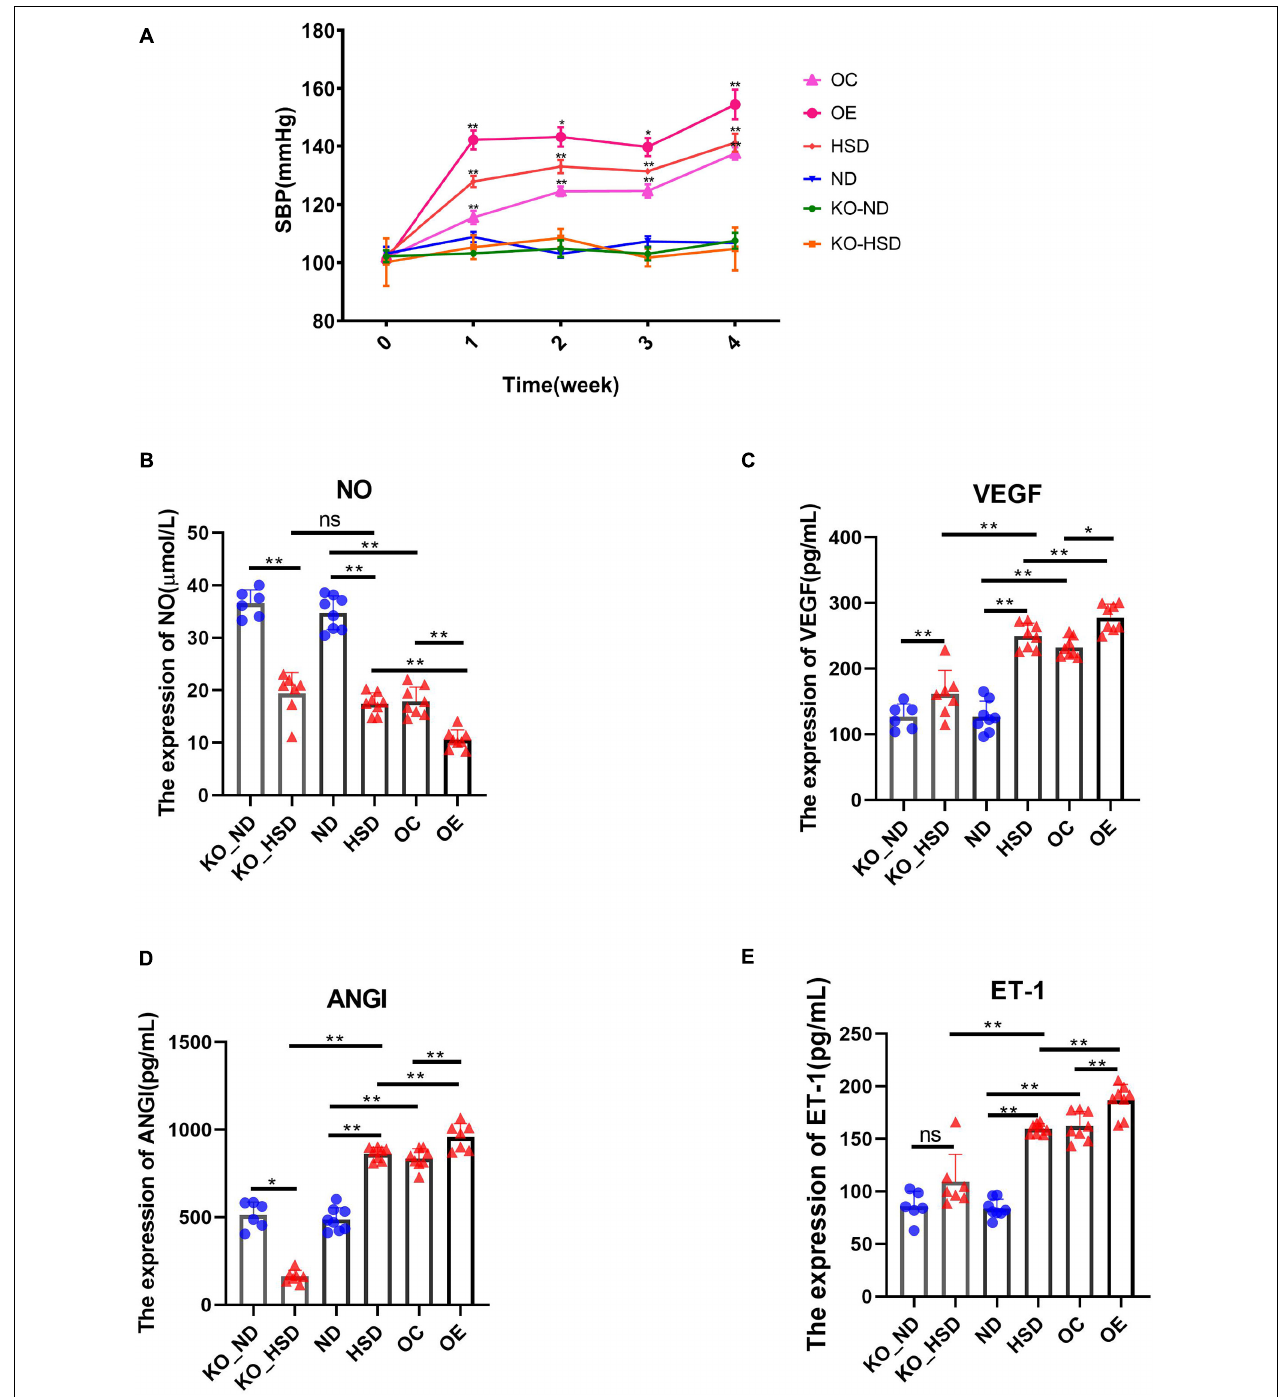
FIGURE 2 | ATF4 altered SBP and endothelial function-related factors in high-salt-induced hypertensive mice. (A) ATF4 altered SBP in high-salt-induced hypertensive mice. ND vs HSD, HSD vs OE, OE vs OC, * p < 0.05 and ** p < 0.01. (B) ATF4 altered the expression of NO in high-salt-induced hypertensive mice. (C) ATF4 altered the expression of VEGF in high-salt-induced hypertensive mice. (D) ATF4 altered the expression of ANGI in high-salt-induced hypertensive mice. (E) ATF4 altered the expression of ET-1 in high-salt-induced hypertensive mice. Data are presented as mean ± SD; ns, no significance, * p < 0.05 and ** p < 0.01, n = 6–8; statistical comparisons were performed using Student t -test or one-way analysis of variance (ANOVA). ATF4, activating transcription factor 4; KO, Atf4 ± mice; WT, wild-type mice; SBP, systolic blood pressure; NO, nitric oxide; VEGF, vascular endothelial growth factor; ANGI, angiotensin I; ET-1, endothelin-1; KO-ND, Atf4 ± mice with natural diet; KO-HSD, Atf4 ± mice with high-salt diet; ND, WT mice with natural diet; HSD, WT mice with high-salt diet; OE, Atf4 overexpression with high-salt diet; OC, Atf4 overexpression control with high-salt diet.